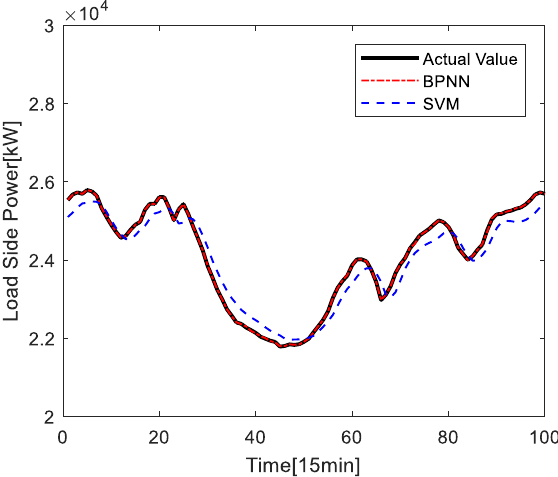
Figure 12. Prediction results of load power in the No. 1 power system.